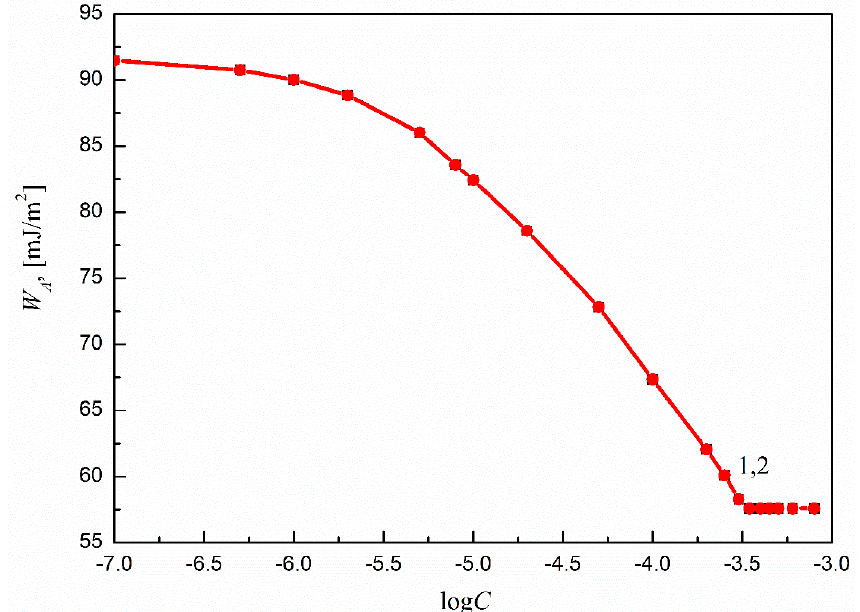
Figure 8. A plot of the work of adhesion ( W A ) of the aqueous solutions of SMD to Ti6Al4V ELI’s surface vs. the logarithm of surfactant concentration (log C S ). Curve 1 corresponds to the W A values calculated from Equation (9).